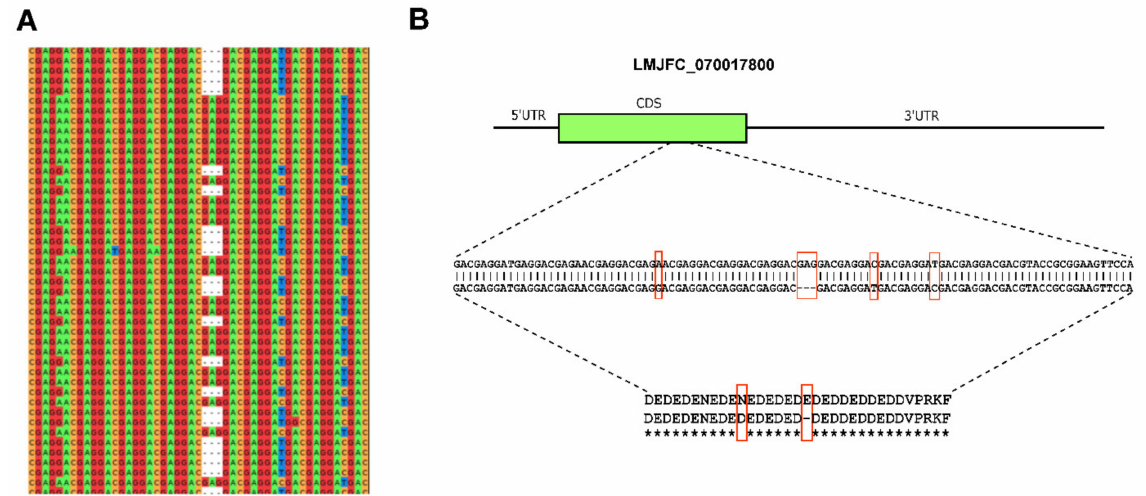
Figure 8. Identification of two distinct alleles for LMJFC_070017800 gene. ( A ) Two haplotype blocks were identified by the HapCUT2 tool and confirmed when Illumina reads mapping to this gene were visualized. ( B ) Scheme of gene structure, location of allelic polymorphisms and differences in the amino acid sequences between both alleles.